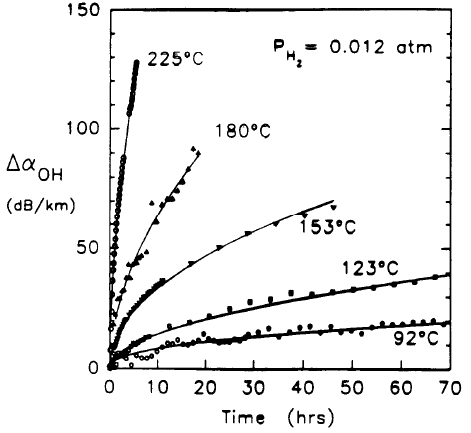
Figure 3. Densification in fused silica under 193 nm irradiation, reprinted with permission from [11]. Copyright 1996 OSA. The optical path difference follows: